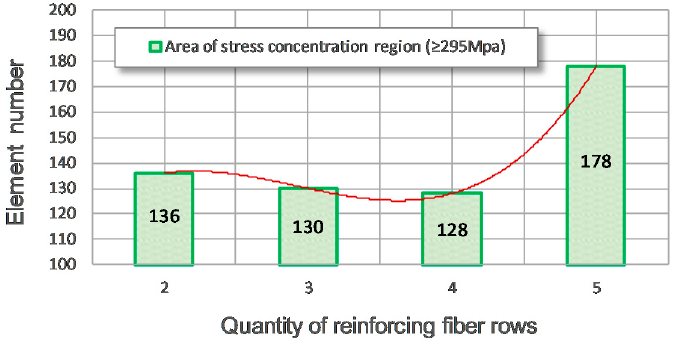
Figure 28. Area of the stress concentration region ( ≥ 295 MPa) for the four stress fields with different quantities of reinforcing fiber rows.